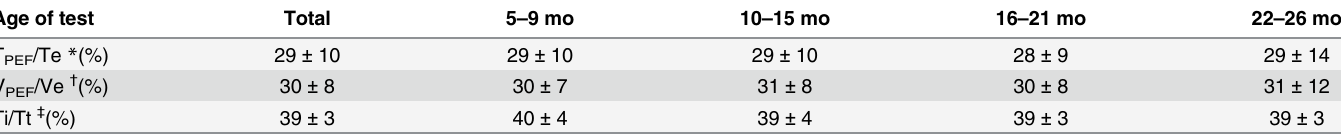
Table 3. Tidal flow parameters, expressed as mean ± standard deviation, of infants in various age